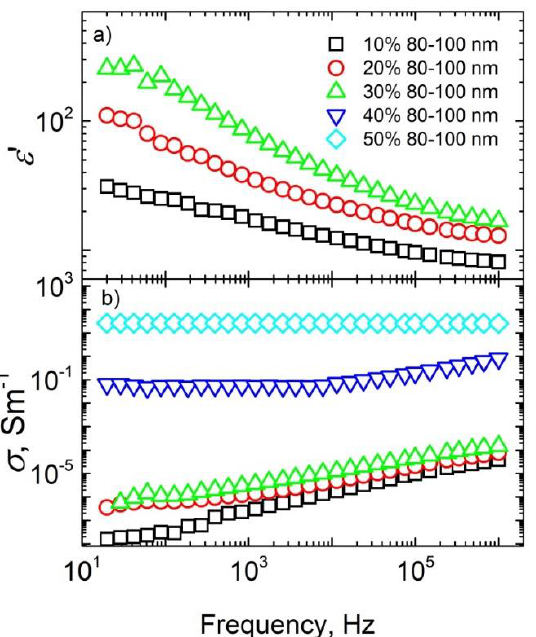
Figure 3. Room-temperature dielectric permittivity ( a ) and electrical conductivity ( b ) of phosphate ceramics with Ag inclusions (80–100 nm nanoparticles) plotted as a function of frequency.